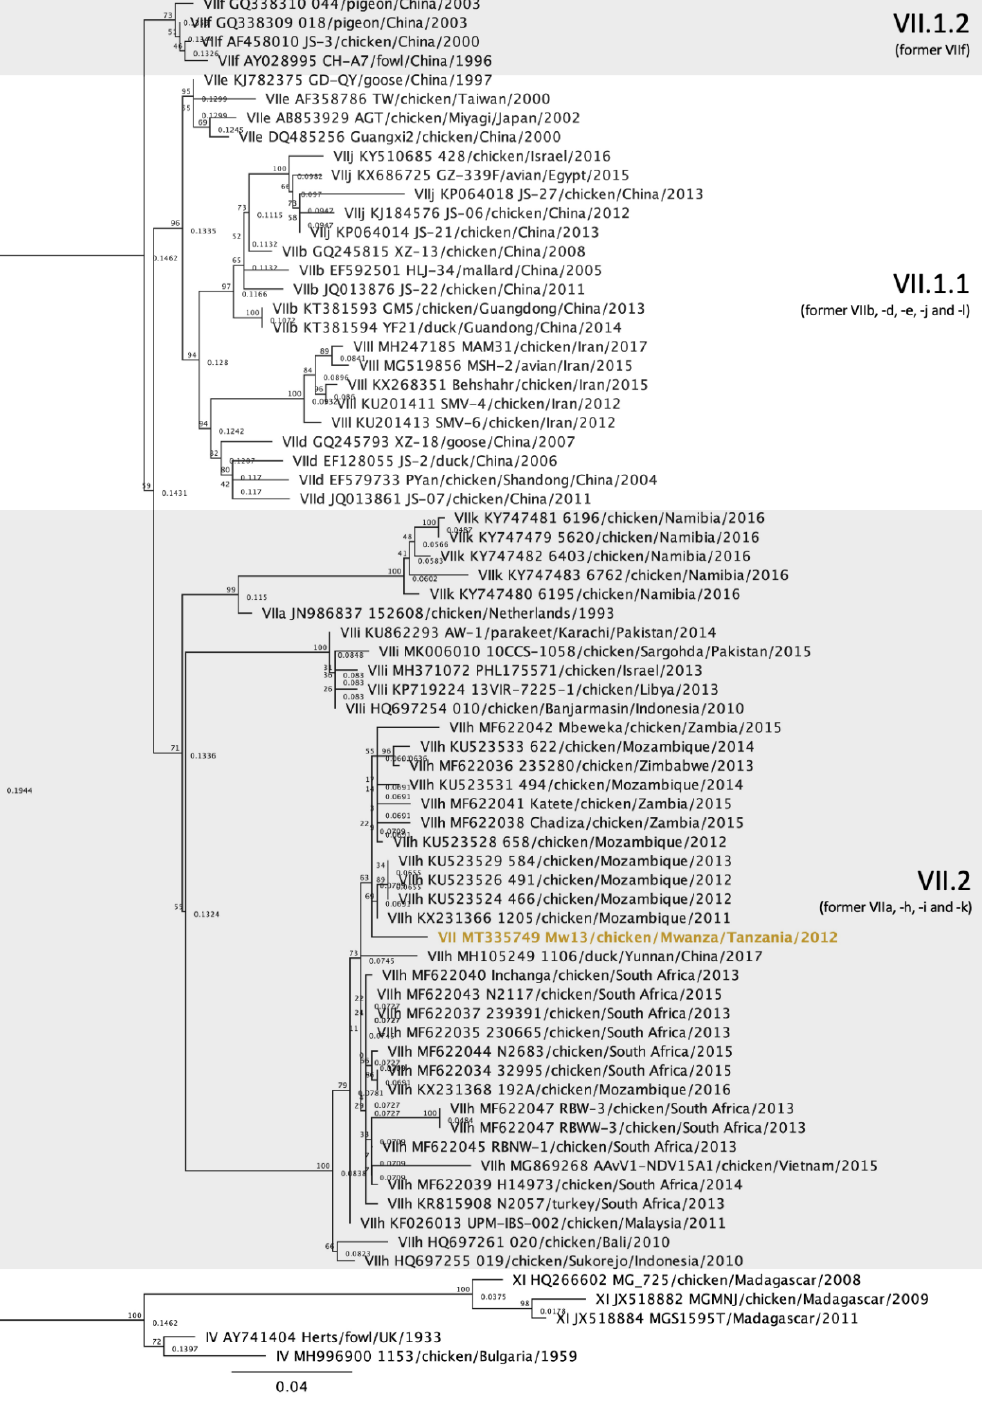
Figure 4. Phylogenetic analysis of Newcastle disease virus genotype VII isolates using a 615-bp fragment of the fusion gene with the maximum likelihood method with 1000 bootstrap replicates. Of the 72 sequences used, one was collected from diseased chickens from Mwanza, Tanzania (bolded and colored), 66 represent other genotype VII isolates [5], and 5 are outliers (2 from genotype IV and 3 from genotype XI). The Roman numerals on the right represent the subgenotypes the isolates belong to. The previous terminology [4] is listed below the current nomenclature in parenthesis for reference.